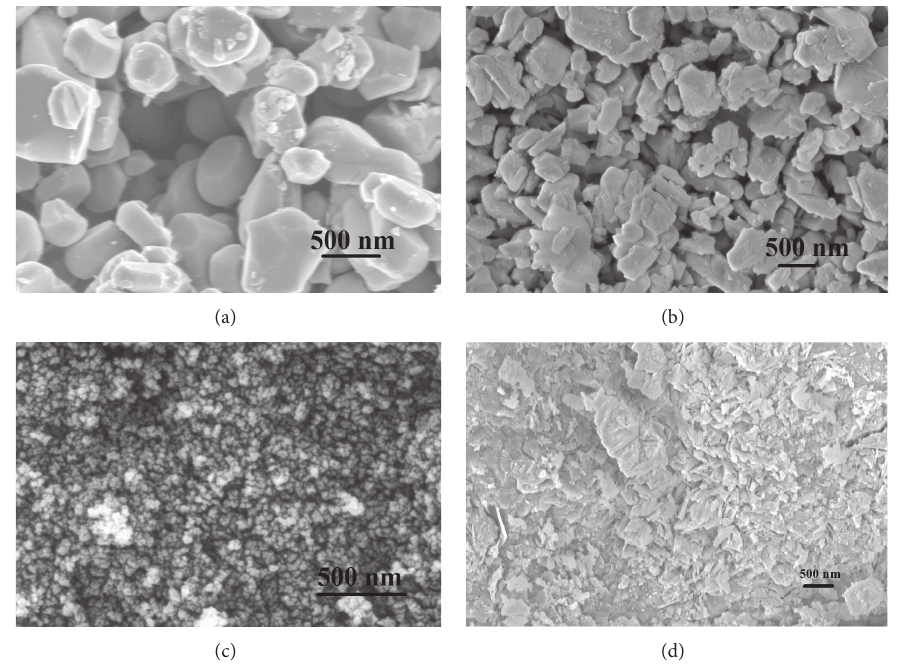
Figure 1: Surface morphology of (a) BaHF, (b) CoTiMn-BaHF, (c) CCB, and (d) TiO 2 particles.